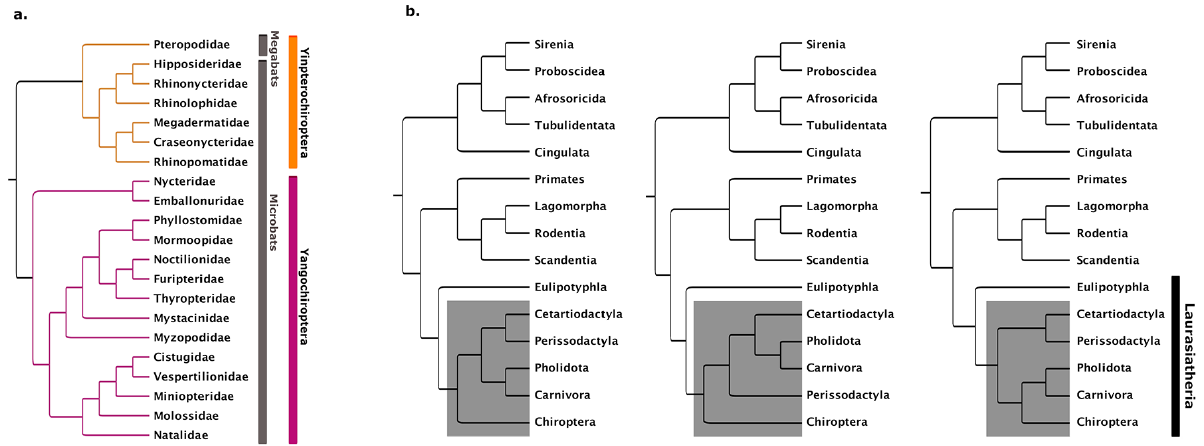
Figure 1 – Phylogeny of bats. (a) Cladogram* showing intraordinal phylogenetic relationships in Chiroptera (adapted from Teeling et al. , 2018). Based on molecular data, Chiroptera is now classified into Yinpterochiroptera (orange) and Yangochiroptera (magenta), while the traditional classification into microbats and megabats is shown in grey. (b) Cladogram* showing the interordinal relationship between Chiroptera and other mammalian taxa (adapted from Jebb et al. , 2020). Three of the best supported tree topologies for the relationship between the Laurasiatherian lineages Carnivora, Perrissodactyla, Cetartiodactyla, Pholidota and Chiroptera (indicated by shaded area) are shown. *Branch lengths do not indicate